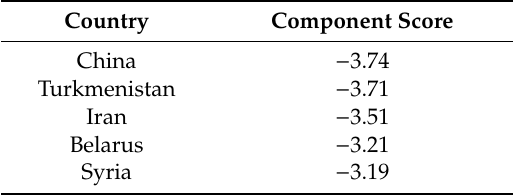
Table 5. Top five negative component scores for Component